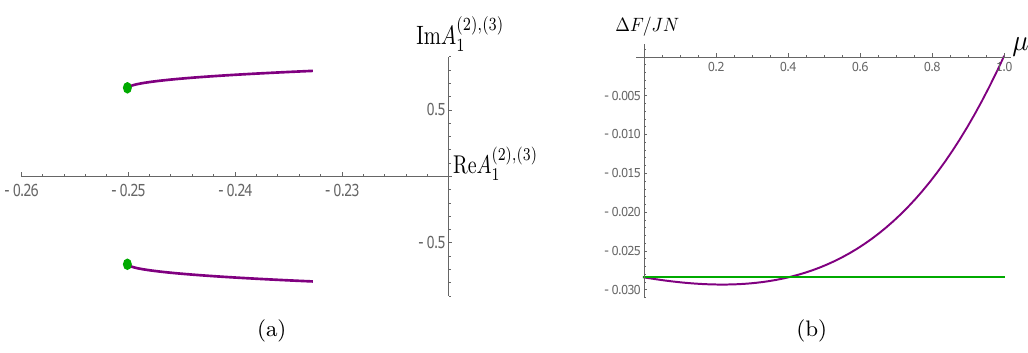
Figure 8 . (a) Trajectories of saddle points (6.13) parametrized by µ on the complex plane. The green points show the location of the replica symmetric solutions. (b) The value of the regularized free energy on solution (6.13) as a function of µ . The green line is the value of the free energy for replica-symmetric solutions (5.66).